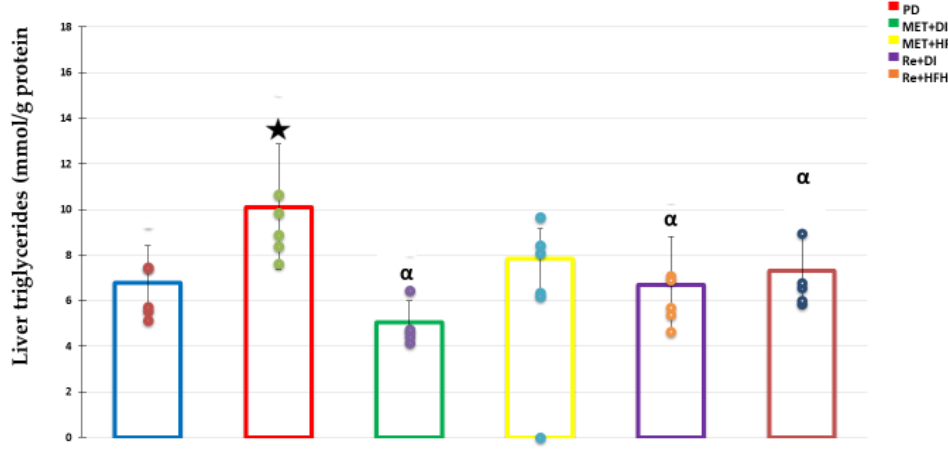
Figure 4. Liver triglycerides concentration in NC, PD, MET + DI, MET + HFHC, Re + DI and Re + HFHC after 12 weeks of treatment. Values are presented as means ± SD and individual data points ( n = 6). * p < 0.05 by comparison with NC, α p < 0.05 by comparison with PC, MET + DI, MET + HFHC, Re + DI and Re + HFHC.